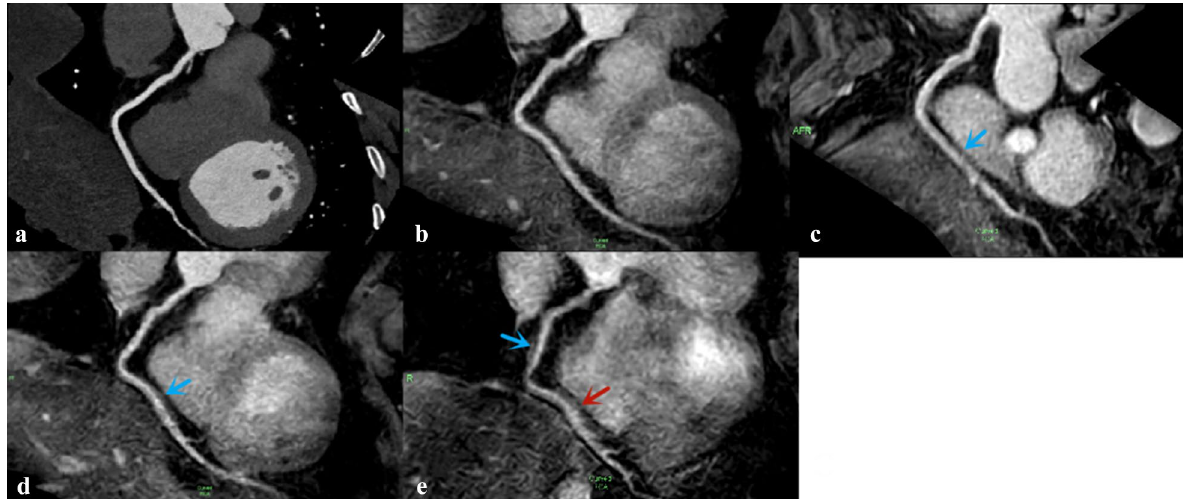
Fig. 9 RCA image of a 41-year-old man acquired via CCTA sequence ( a ) and four NCMRA sequences. On the image from SENSE sequence ( b ), the blood vessels were well depicted with sharply defined borders, and the score was 4. The distal segments of RCA from CS4 sequence ( c ) and CS5 sequence ( d ) were adequately visualized with only mildly blurred borders, and the score was 3 ( blue arrow ). On the image from CS6 sequence ( e ), the proximal and middle segments of RCA were adequately visualized ( blue arrow ), but the distal part was visible with moderately blurred borders; the score was 2 ( red arrow